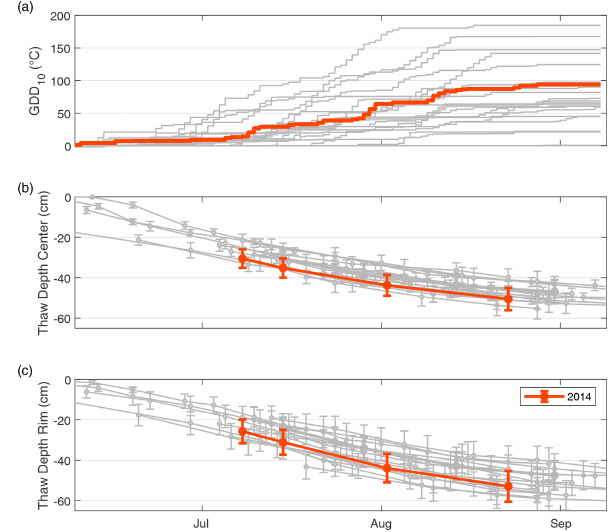
Figure A1. Cumulative growing degree days (GDDs; a ) and thaw depths in the center (b) and the rim (c) of a polygon between 8 June and 8 September of 2002–2018. The year 2014 is highlighted in orange. All other years are displayed in gray.